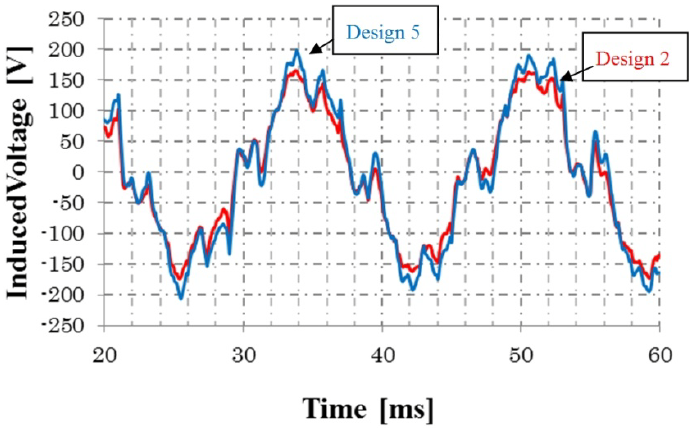
Figure 19. Induced voltages of Design 2 and Design 5.